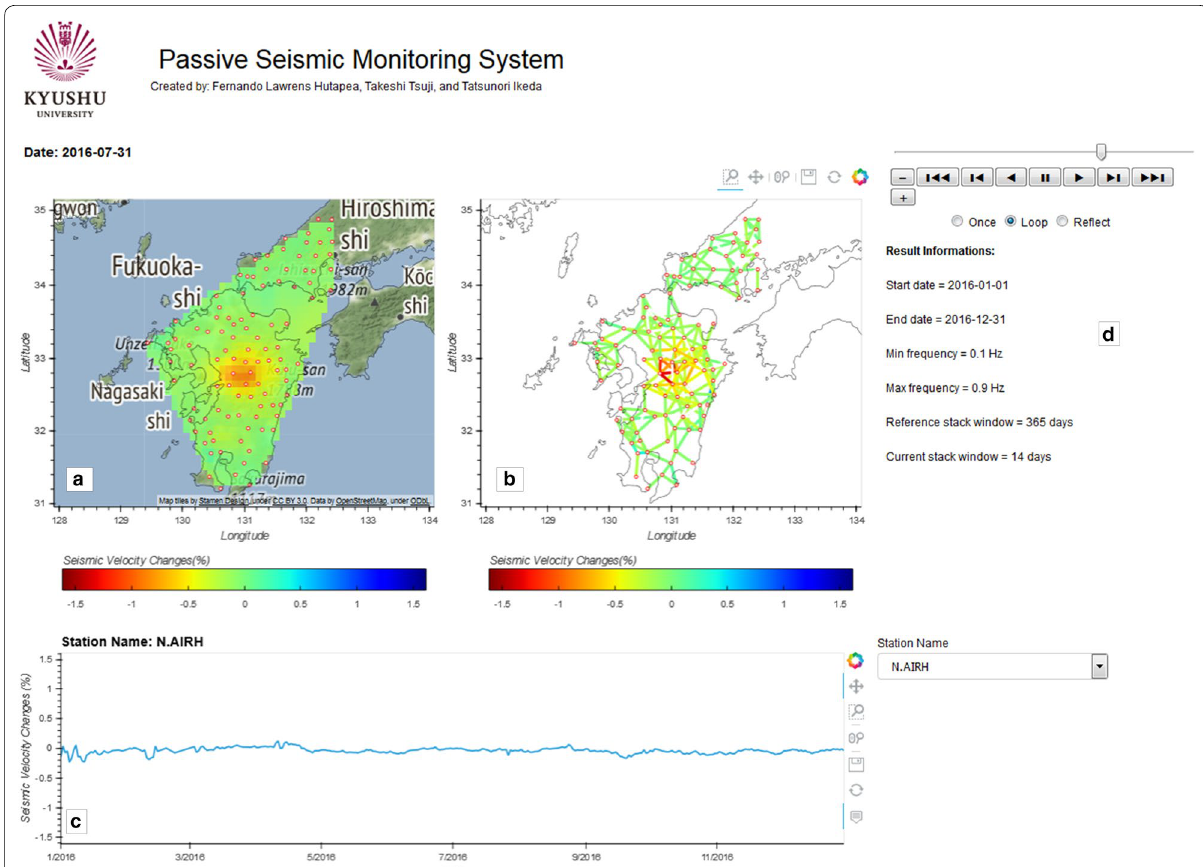
Fig. 11 Template of the web application. a Spatio-temporal velocity changes in Kyushu; b temporal velocity variations for all station pairs; c spatio-temporal velocity variations for individual stations, and d attributes of the data used to calculate velocity variations. This template of web application design is not fixed, because we will update the design in the future in order to improve the feature and